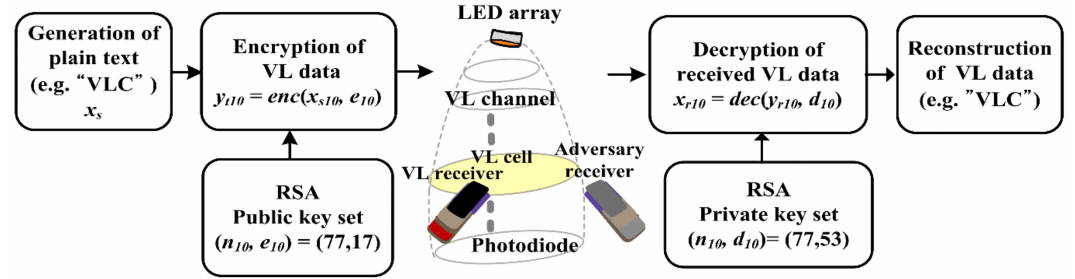
Figure 3. Key function diagram for asymmetric Rivest–Shamir–Adleman (RSA) encryption and decryption processes in proposed VL communication technique for smart indoor service of Figure 1.